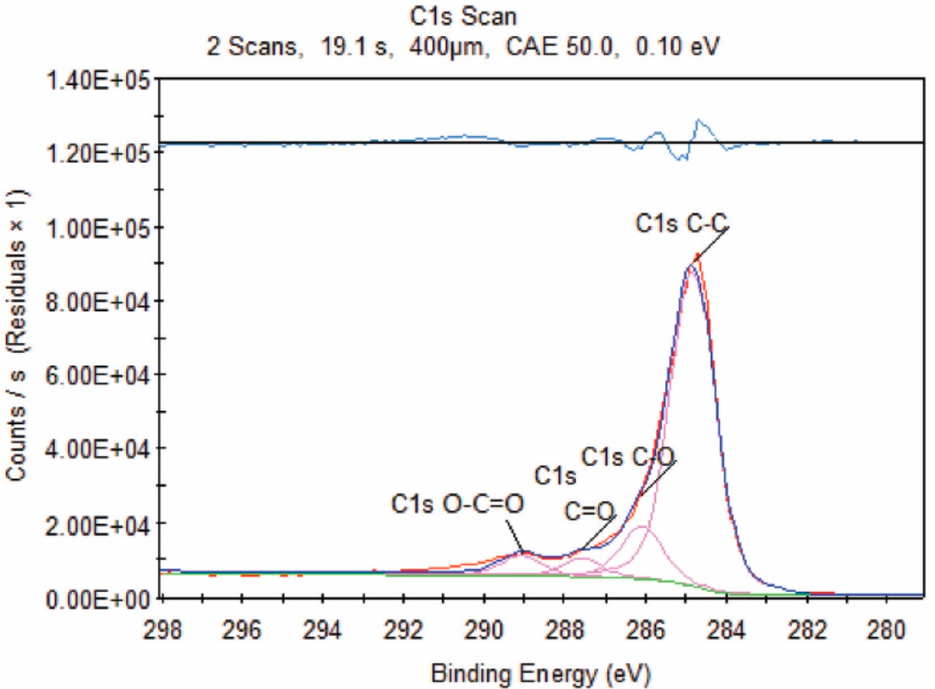
Figure 5. Peak deconvolution of C1s of the graphene modified with oxalic+citric30.